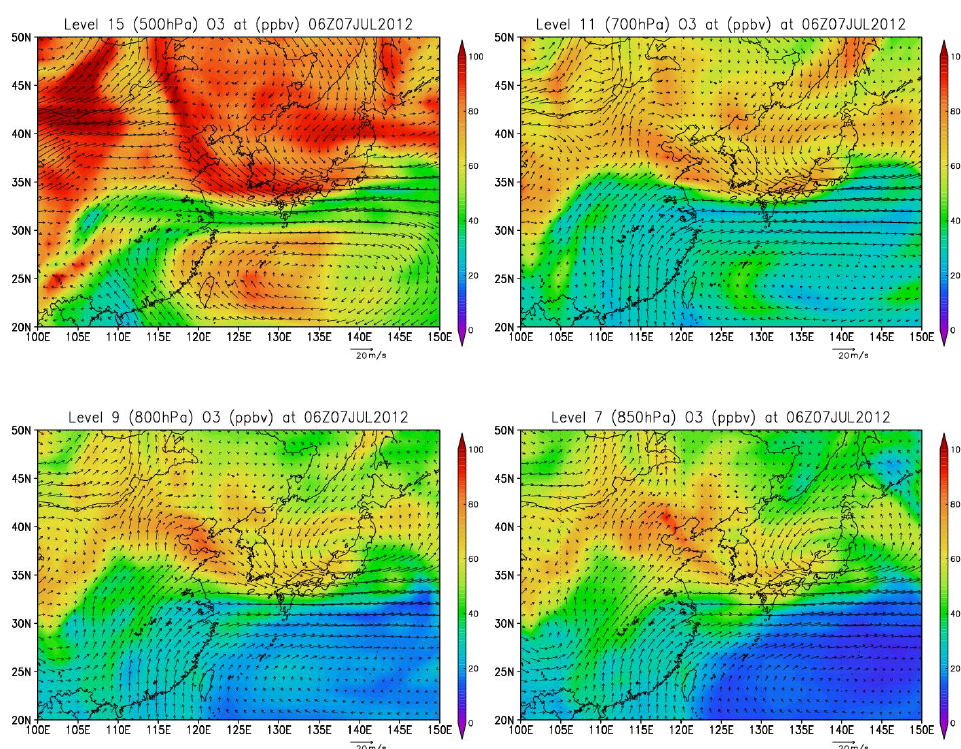
Figure 6. Horizontal maps of ozone volume mixing ratio in ppbv and horizontal wind in ms − 1 predicted by MRI-CCM2 for 500, 700, 800, 850hPa pressure levels at 06:00UTC on 7 July 2012.